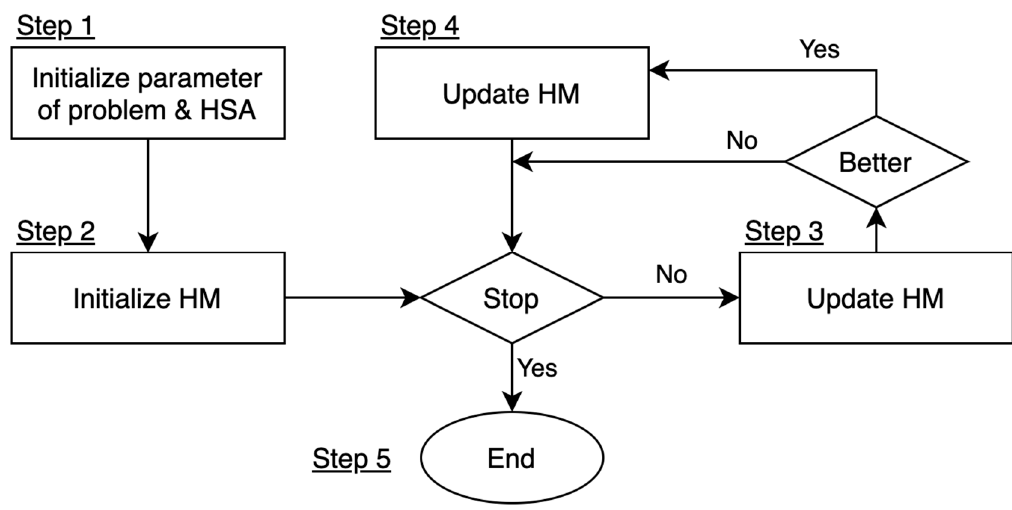
Figure 2. Flowchart of Harmony Search (HS).